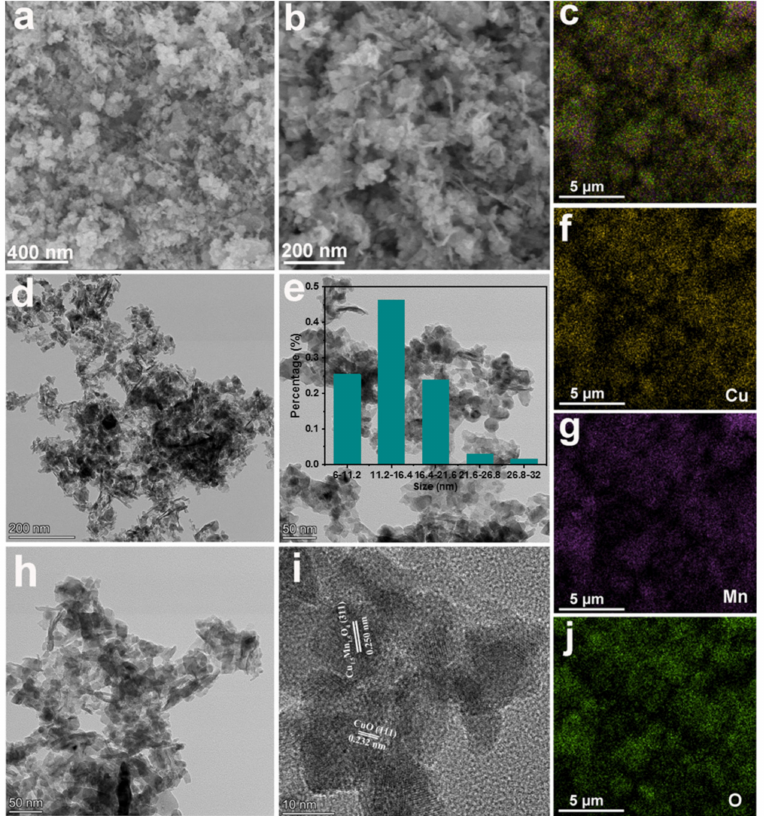
Figure 2. ( a , b ) the SEM images; ( d , e , h ) TEM images; ( i ) HRTEM image; and ( c , f , g , j ) the corresponding element mapping patterns of CuO x /Cu 1.5 Mn 1.5 O 4 .